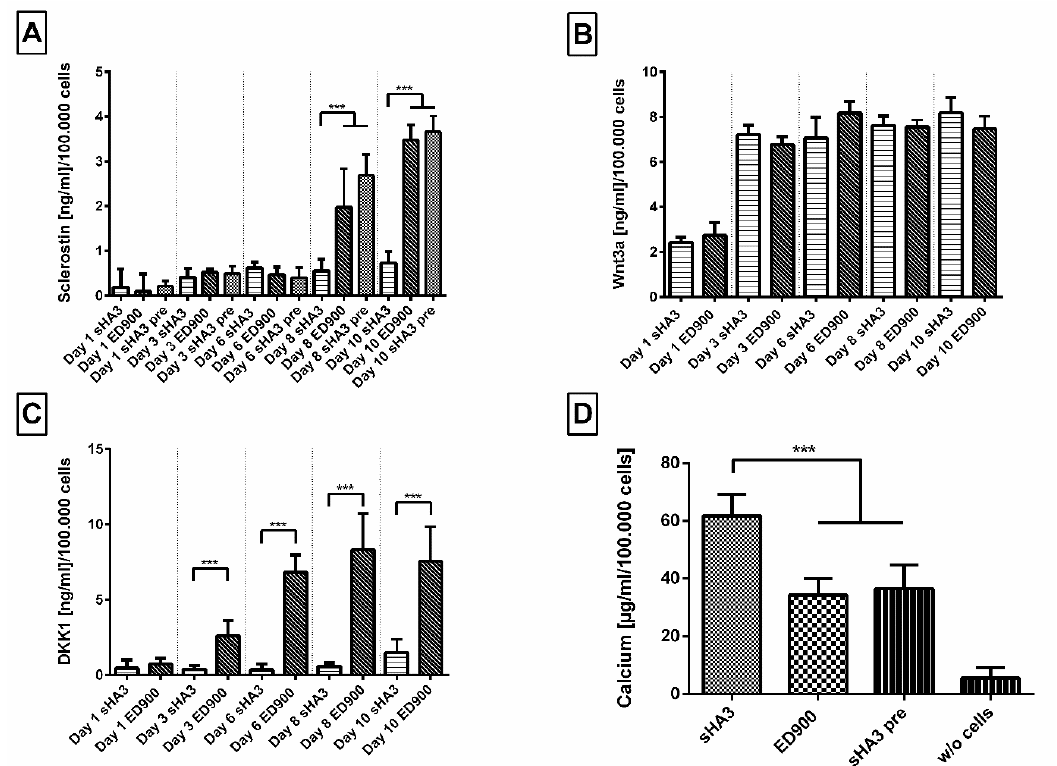
Figure 9. E ff ect of film modification on secreted protein content in the supernatant and mineralization during osteogenic di ff erentiation of SaOS-2 cells. Cells were seeded on di ff erently modified surfaces at a density of 10,000 / cm 2 and di ff erentiated for 10 days. ( A ) Sclerostin, ( B ) Wnt3a, and ( C ) DKK1 were then quantified from the cell supernatant via ELISA after 1, 3, 6, 8, and 10 days. Calcium content ( D ) was quantified at day 10. Film surfaces: ED900: surface coating with ED900 preincubated with soluble sHA3; sHA3: covalent ED900 and sHA3-coating; sHA3 pre: sHA3 surface preincubated with 40 ng / mL sclerostin; w / o cells: sHA3 surface without seeded cells. All values represent the mean ± SD of n ≥ 4. *** p < 0.001 denotes significant di ff erence vs. the respective surface modifications.